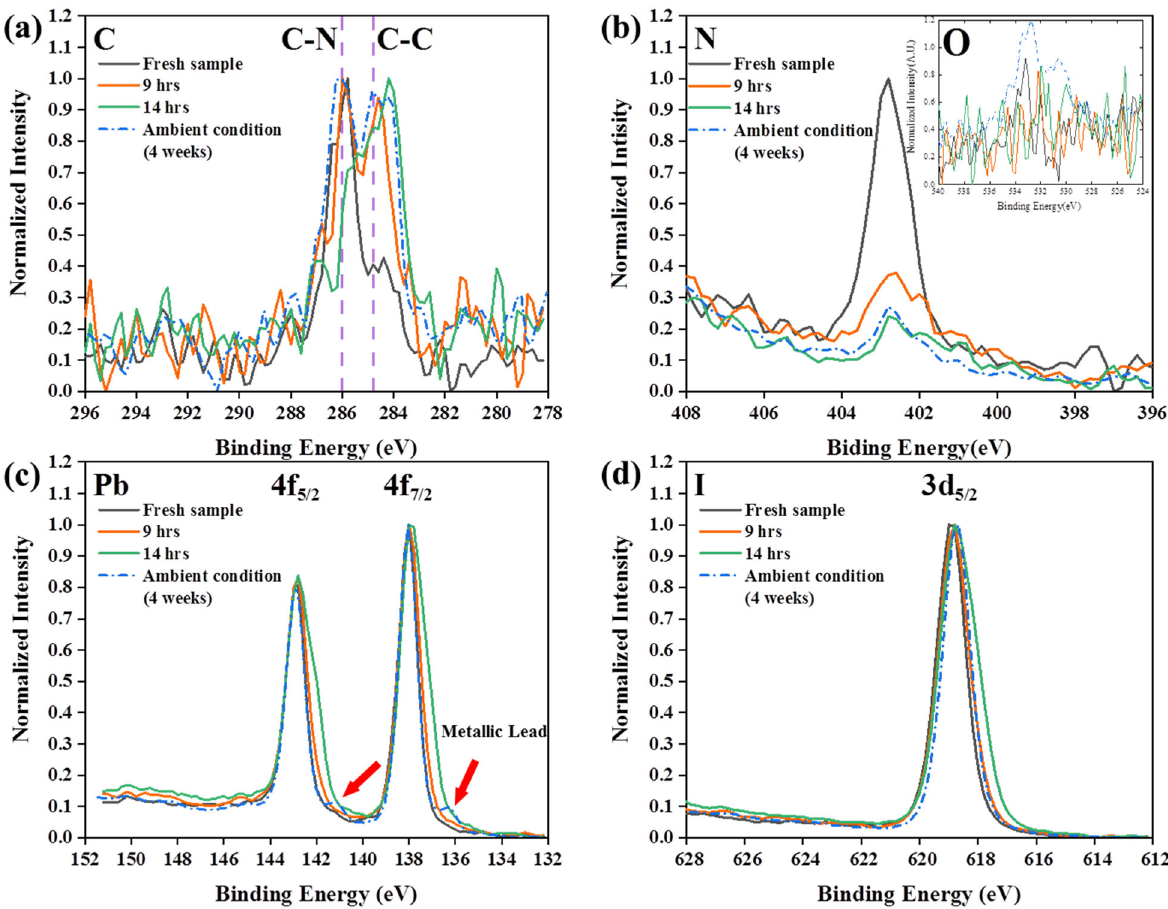
Fig. 2 Surface chemistry of the primary elements. XPS spectra of a carbon, b nitrogen, c lead and d iodine peaks upon exposure to the X-ray source used in XPS for 20 min (fresh sample), and 9 h, 14 h and those of the sample stored in ambient conditions for 4 weeks (w.o. X-ray exposure). The inset fi gure in the N spectrum illustrates the oxygen